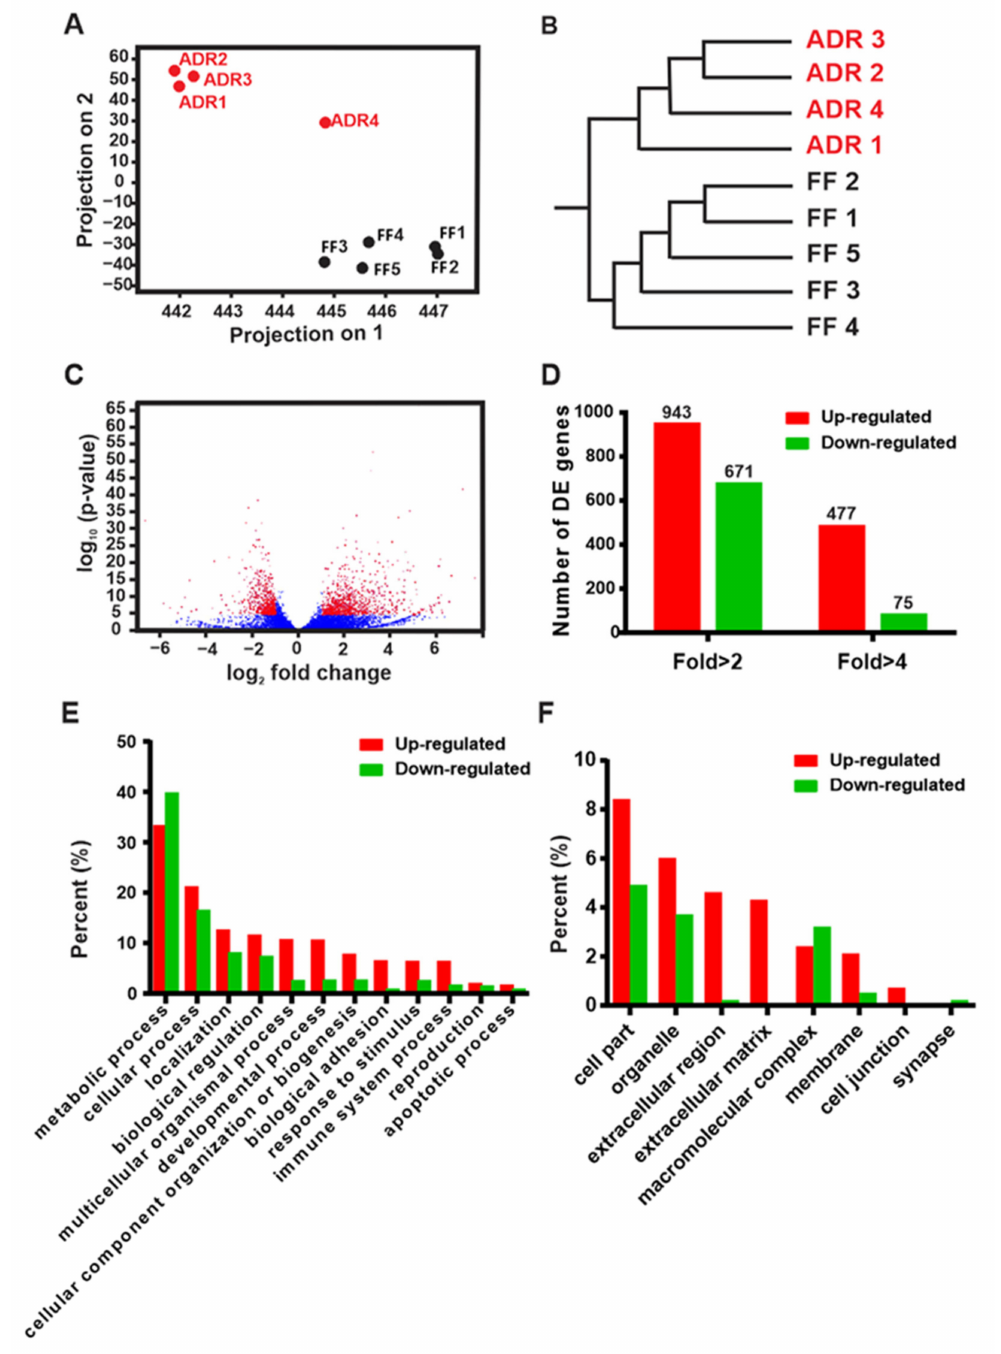
Figure 1. Quality control analysis of the transcriptomic profiles and primary functional clustering of differentially expressed genes by PANTHER online analysis. ( A , B ) PCA and HCA analysis of each biological replicate. ( C ) Volcano plot of DEGs (significant hits are marked in red; other detected genes in blue). ( D ) Number of DEGs with two- and four-fold changes in expression. ( E , F ) Results of the PANTHER online analysis [13,14] of DEGs submitted: ( E ) biological processes and ( F ) cellular